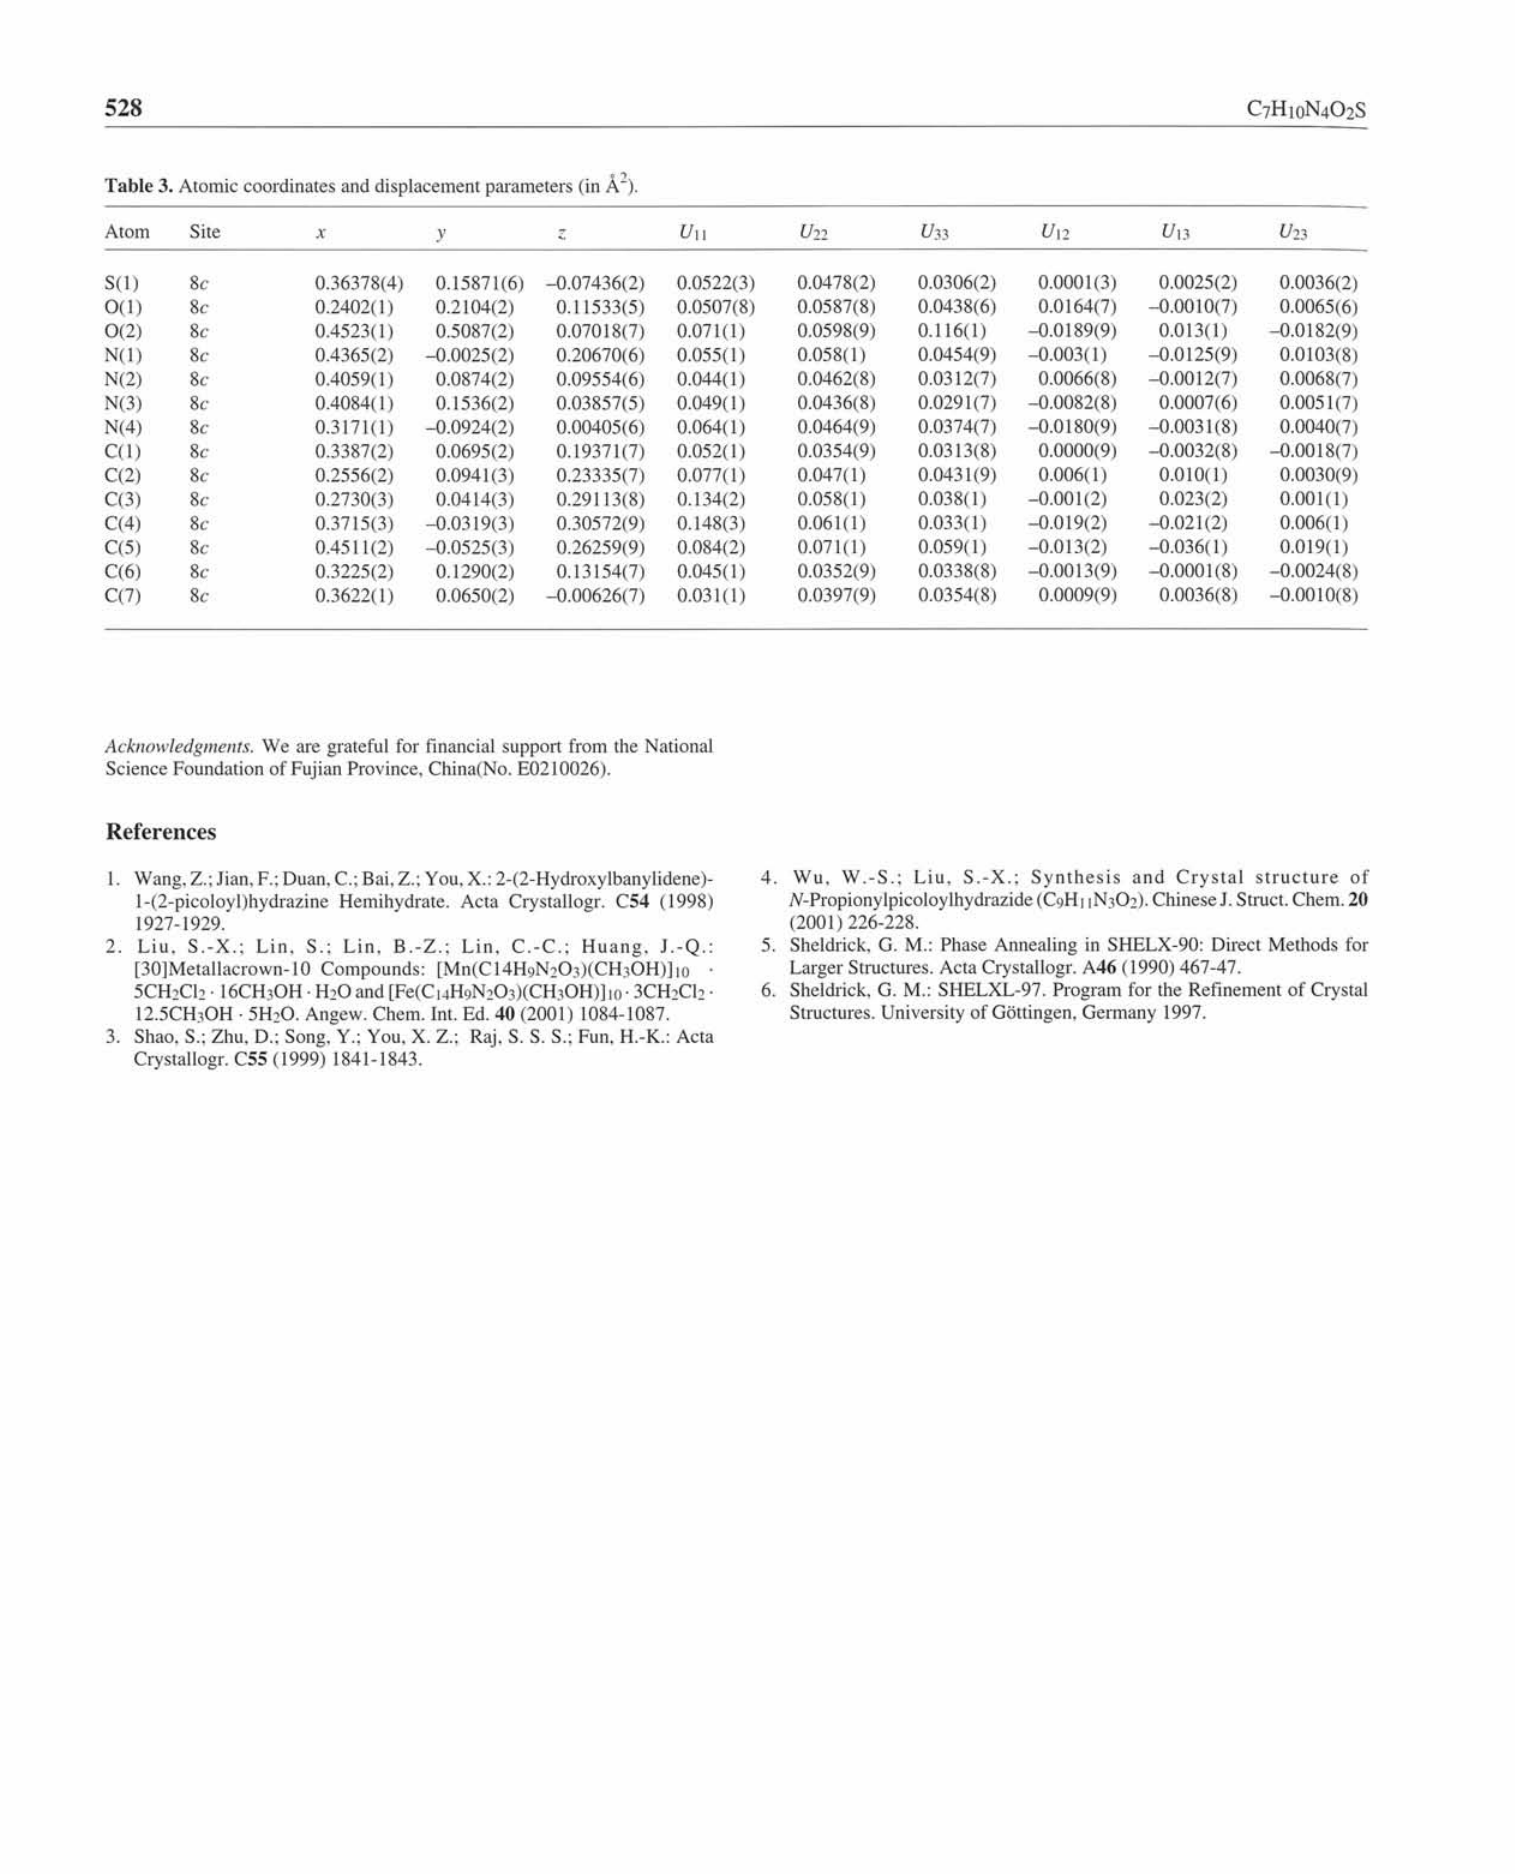
ο Τ Table 3. Atomic coordinates and displacement parameters (in